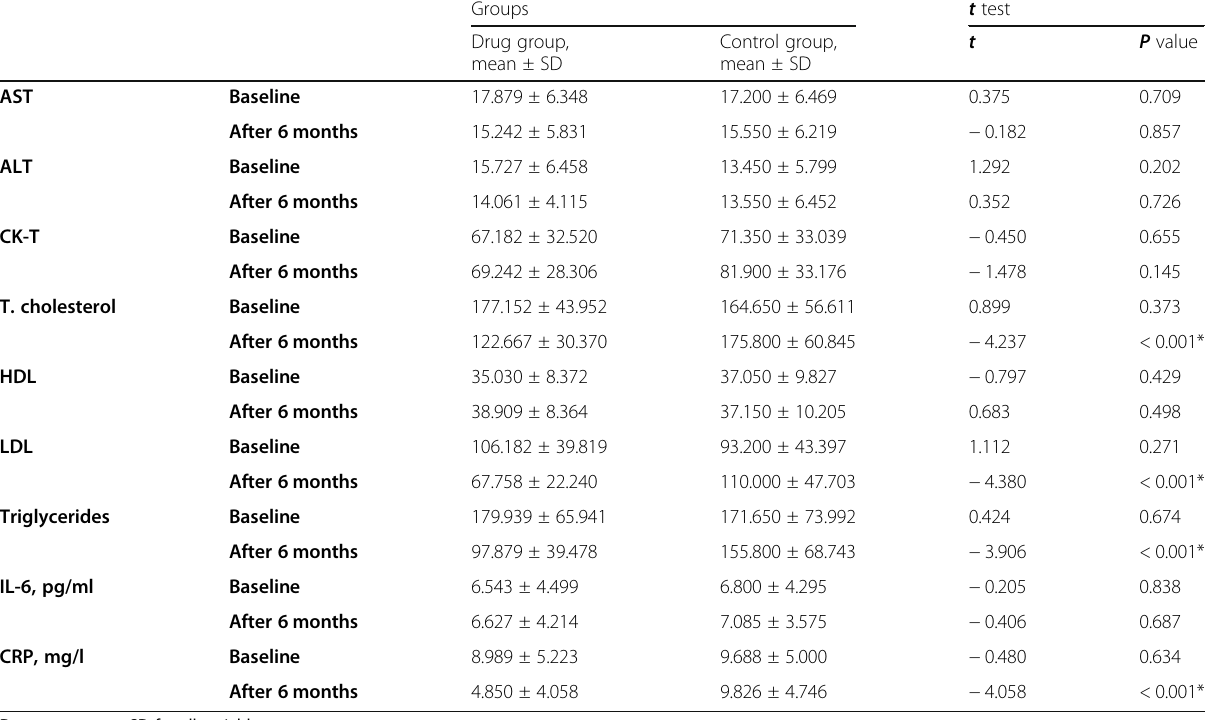
Table 2 Comparison between the drug and control groups as regards the biochemical data at baseline and after 6 months Groups